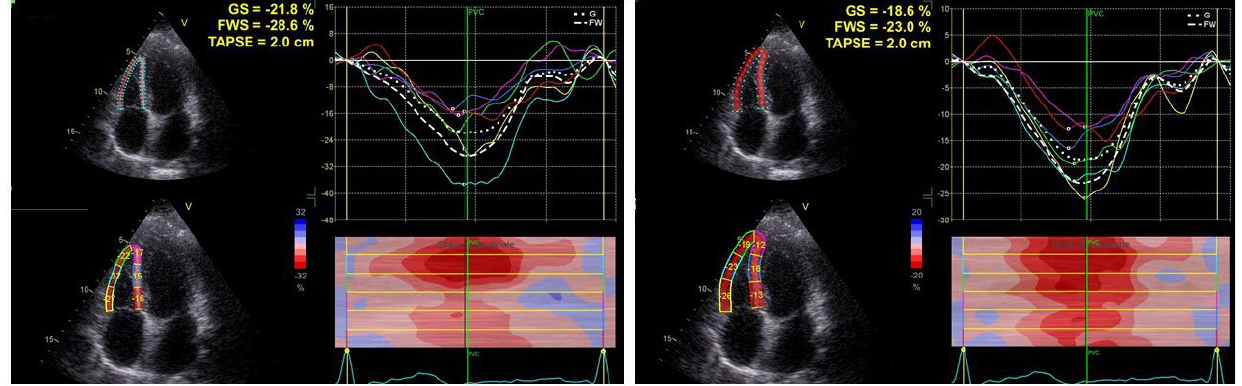
Figure 1. Representative images of right ventricle strain analysis in a healthy control ( left panel ) and in a patient affected by fibrotic interstitial lung disease ( right panel ). RV-to-arterial coupling was estimated as the ratio between TAPSE or RV GLS and sPAP. Cut-off values ≤0.31 mm/mmHg or ≤0.35%/mmHg , respectively, were used to de- fine RV uncoupling, as previously described [5,22]. Left chamber (size and function) quan- tification was assessed as previously described [17,19]. Left ventricle (LV)-STE acquisition was obtained in the three apical views (long-axis, 4-chamber, and 2-chamber) and RV-STE acquisition was obtained in the four apical views according to our laboratory standards [23,24]. Post-processing was performed offline on a dedicated workstation (EchoPAC soft- ware only version 204, GE Healthcare, Chicago, IL, USA). LV longitudinal strain was measured as the segmental peak strain before the aortic valve closure of 6 segments (basal, medium, and apical segments for each wall) in each of the three apical views (4-chamber,